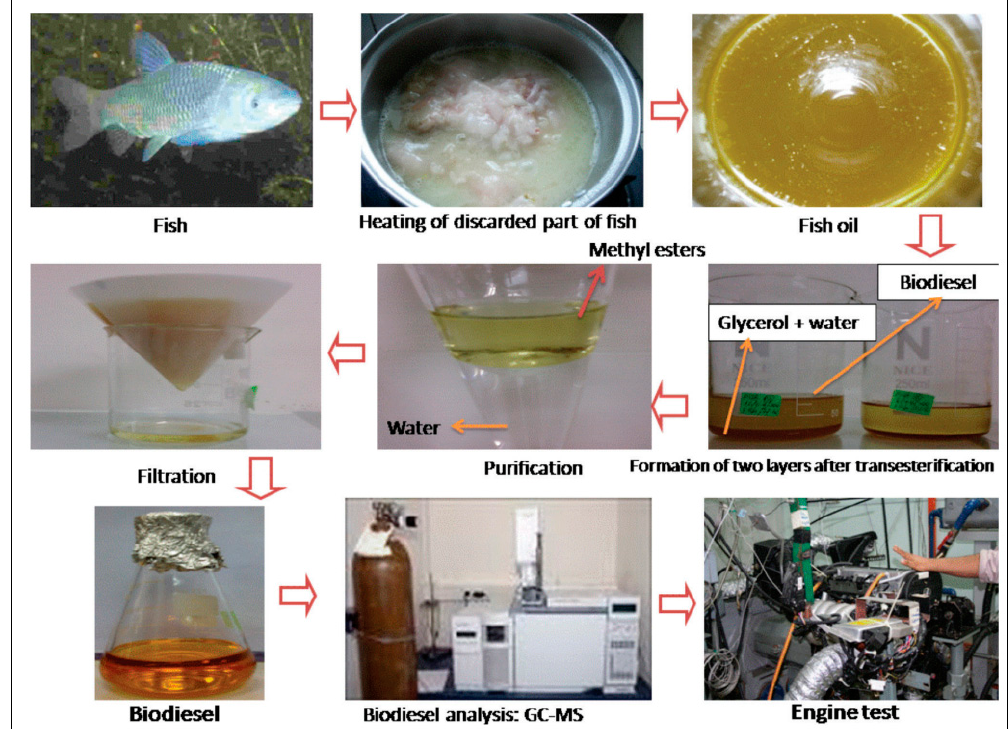
Figure 2. Step-wise preparation of fish oil biodiesel [30].